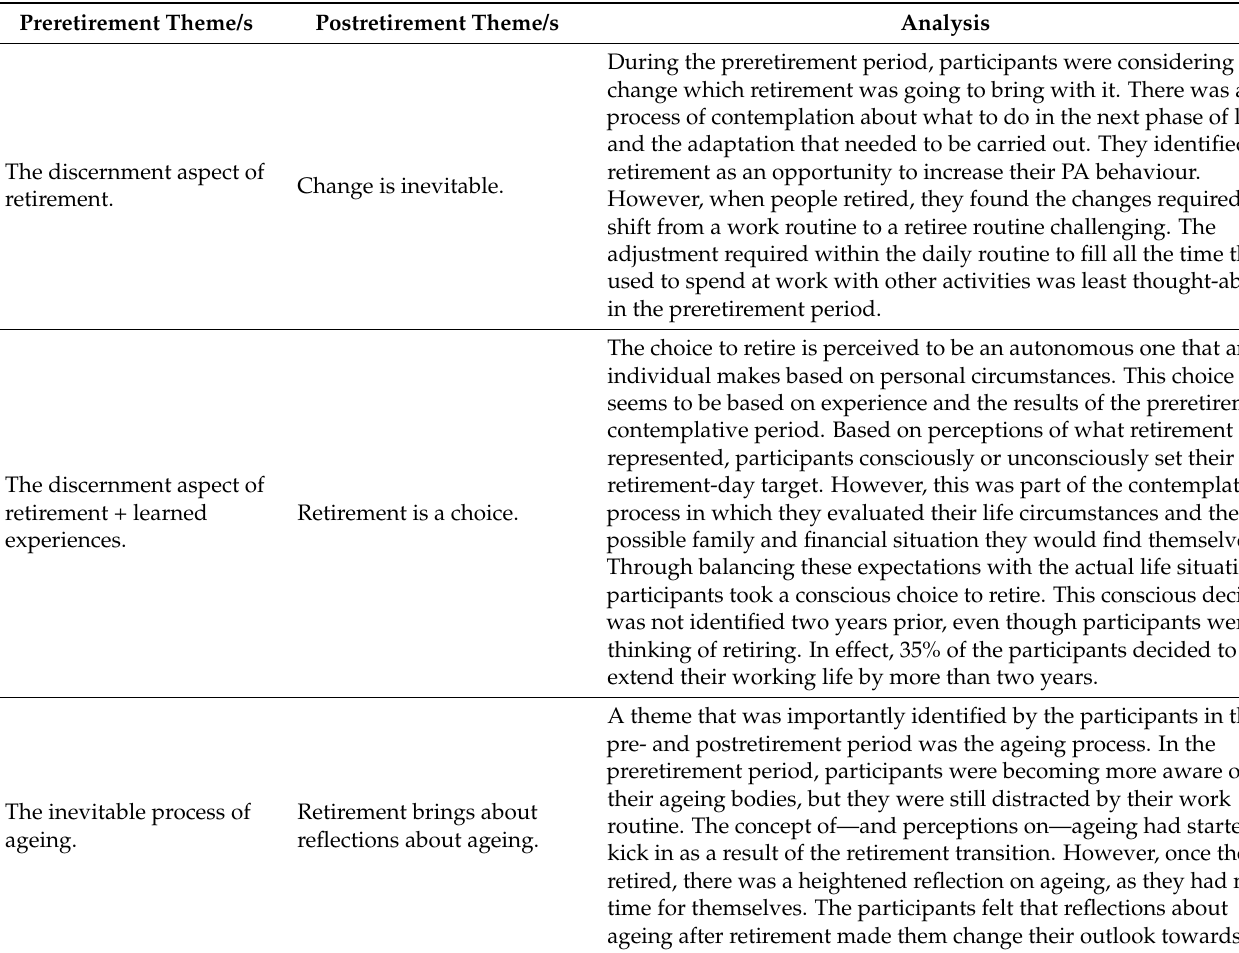
Table 6. Longitudinal analysis of reflexive thematic